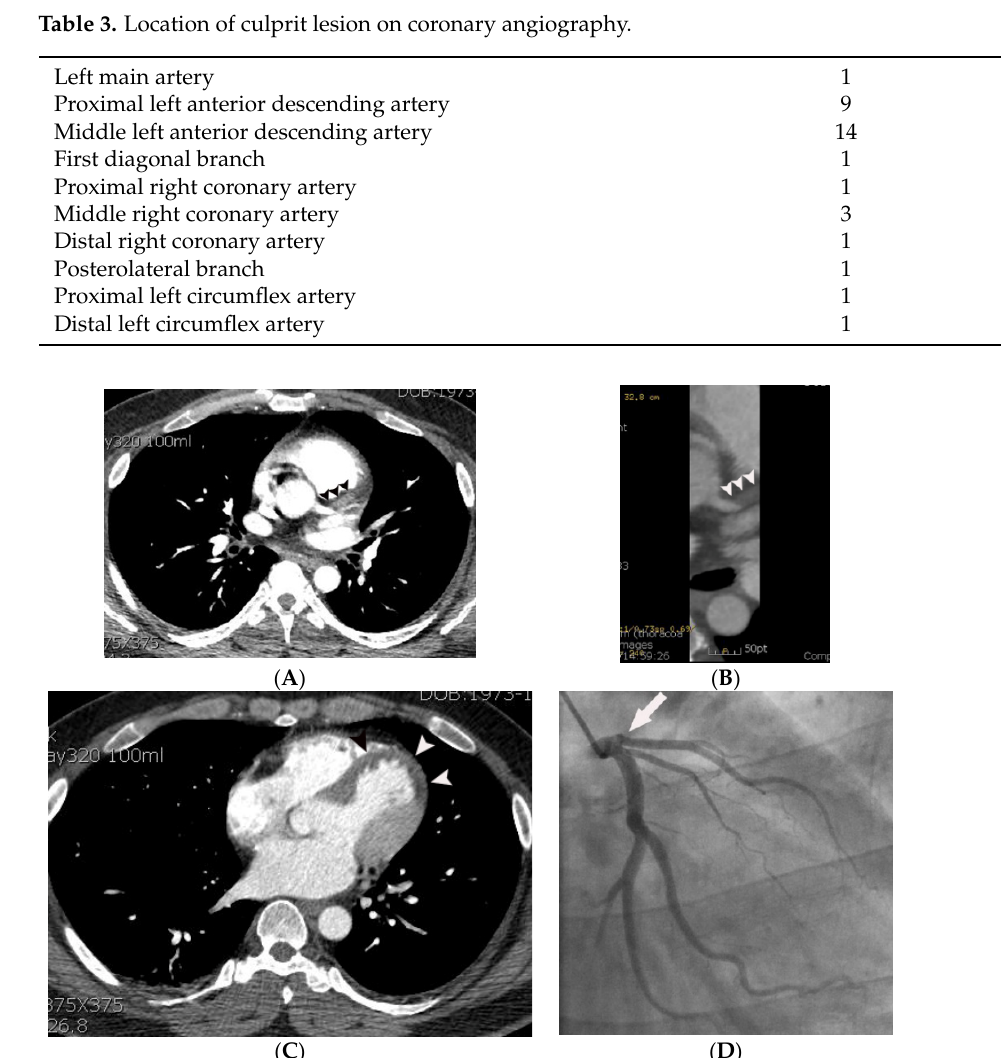
Figure 3. Coronary artery occlusion demonstrated on non-gated enhanced chest CT in a 44-year-old man with acute myocardial infarction. ( A ) An abrupt cut-off (arrowheads) of contrast was noted at the origin of the left anterior descending coronary artery on an axial image at the level of the aortic root. Note that only minimal motion artifact is present in this non ECG-gated image. ( B ) The same finding (arrowheads) was demonstrated more clearly on a curved multi-planar reformatted image. ( C ) A probable myocardial perfusion defect (CT grade 2) (arrowheads) was noted in the left ven- tricular apex on an axial image at the level of the left atrium. ( D ) Subsequent coronary angiography confirmed the CT finding (arrow). Table 2. Differences in the CT scores for myocardial perfusion defect between groups 1 and 2.